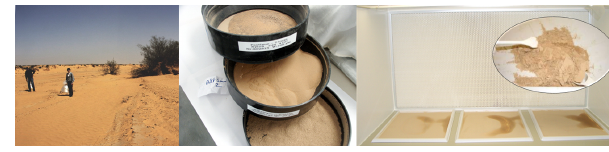
Fig. 3. The different steps of DUNE: (left panel) sampling soils in a region of southern Tunisia where Saharan aerosol is produced and is typical of inputs to the Northwestern Mediterranean. (Center panel) Soil collected in the three stages of the dry sieving column at the end of the fine-particle production process. (Right panel) Artifi- cial aging of the atmospheric particles to mimic the wet deposition, done in a clean room to reproduce the processes taking place dur- ing aerosol transport (photos: F. Dulac, CEA; S. Tran, LISA) (taken from Guieu et al.,